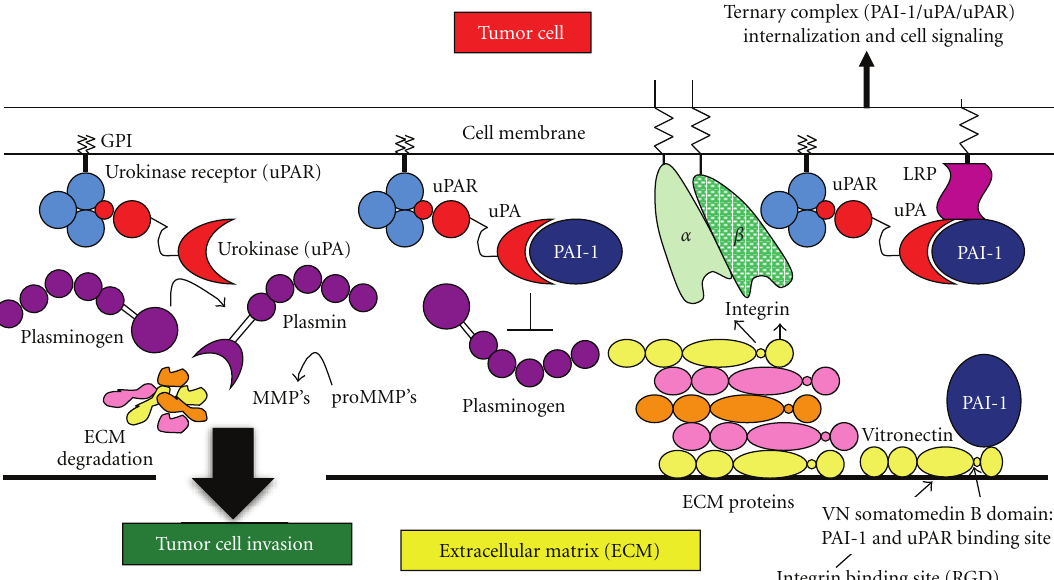
Figure 1: Plasminogen Activator System at the Tumor Cell Surface . Besides its traditional role as a protease inhibitor, the multiple roles of PAI-1 including cell de-adhesion, proliferation/apoptosis, and cell signaling suggest that PAI-1 expression in the tumor microenvironment enhances tumor cell progression. ( Left panel ) The catalytic activity of urokinase (uPA) is enhanced when bound to the cell surface by uPAR. uPA cleaves the zymogen plasminogen to its active form, the serine protease plasmin. Plasmin can subsequently activate matrix metalloproteases (MMP’s) in the extracellular matrix (ECM) microenvironment. Thus, the uPA/uPAR complex and MMP activation contribute to tumor cell invasion and metastasis by degradation of ECM components. ( Middle panel ) PAI-1 directly inhibits the active site of uPA whether it is free or bound to uPAR, and reduces further activation of plasminogen to plasmin. The PAI-1 paradox exists because this inhibition reaction should reduce tumor cell progression and invasion. ( Right panel ) When uPA is neutralized by PAI-1, the trimeric PAI-1/uPA/uPAR complex is recognized by the lipoprotein related protein (LRP) and internalized. Furthermore, PAI-1 has vitronectin (VN) binding sites and causes tumor cell detachment away from the ECM. This figure is based on a schematic from [13].